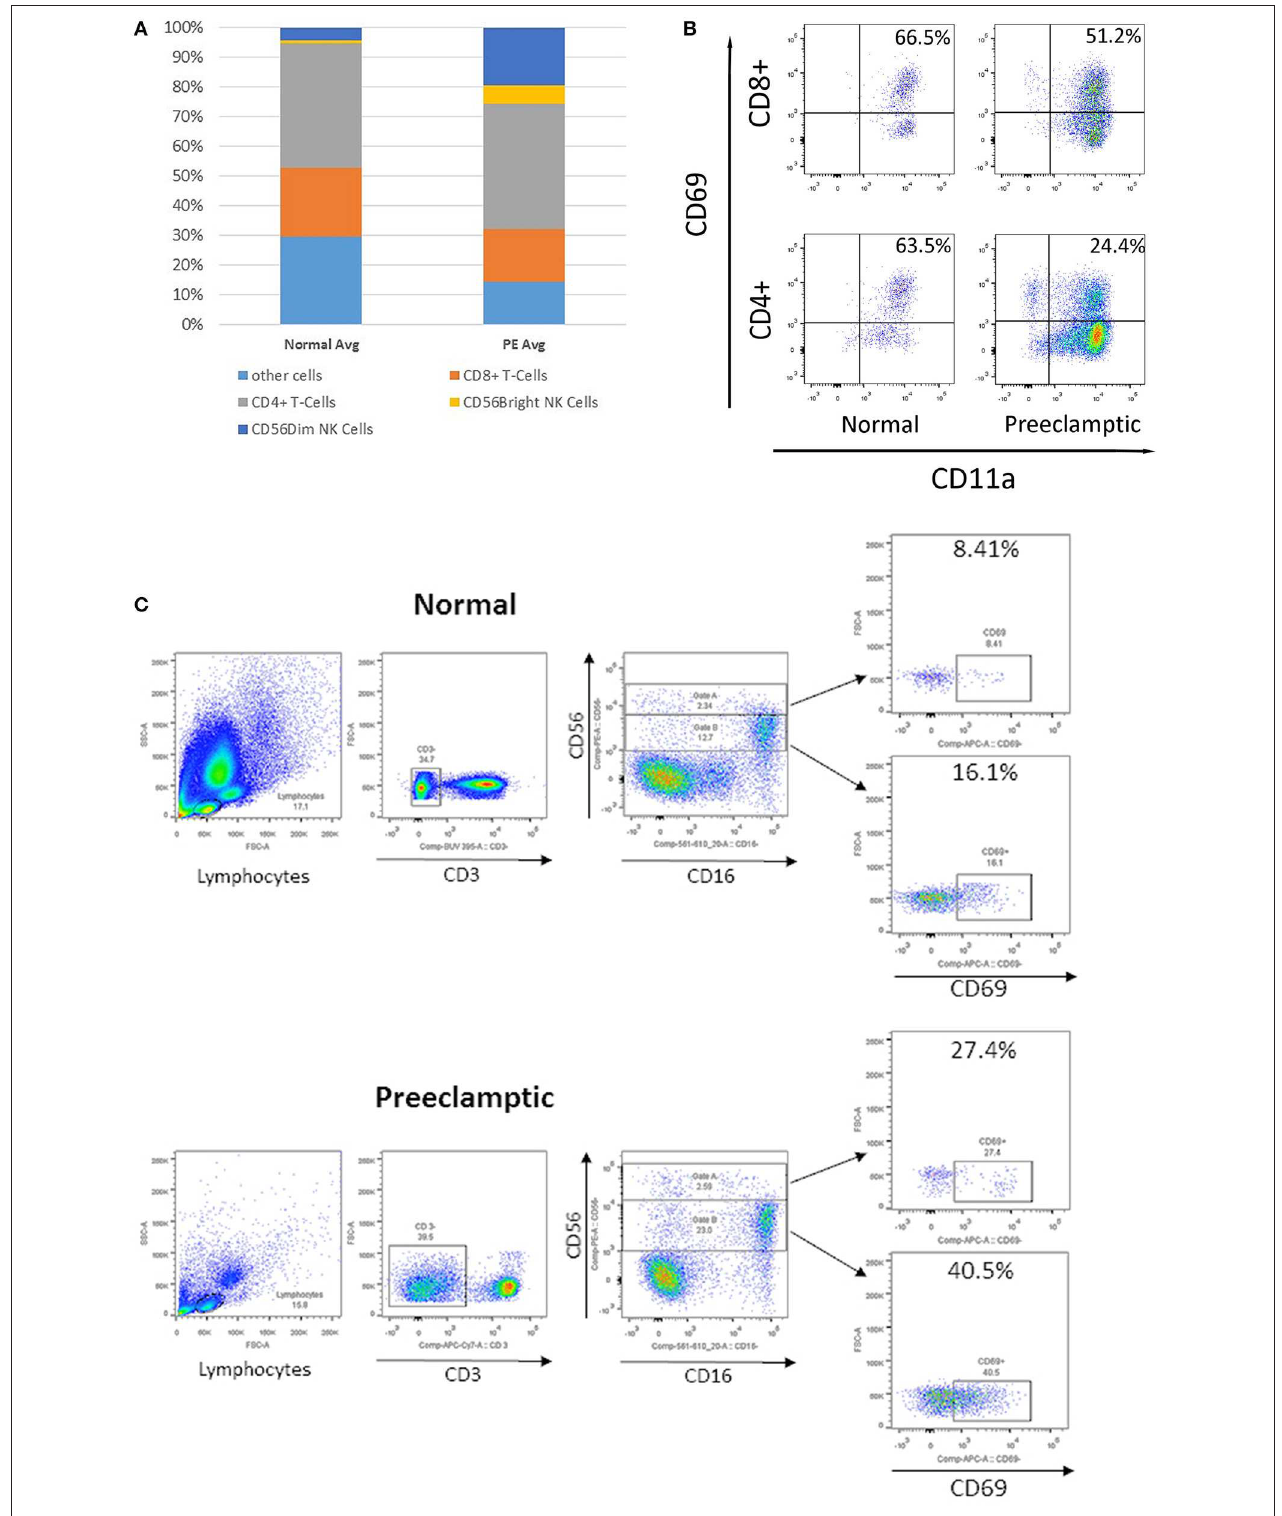
FIGURE 4 | Flow cytometry analysis of peripheral immune cells in blood from normotensive control and pre-eclampsia (PE) women taken before delivery. (A) The relative proportion of T cells and natural killer (NK) cells. (B) Flow cytometry analysis of CD69 + , CD11a + , CD8 + , and CD4 + T cells. (C) Analysis of CD3–, CD56 + , and CD16 + NK cells, divided into CD56 Bright (Gate A) and Dim NK cells (Gate B), and early activation CD69 + .